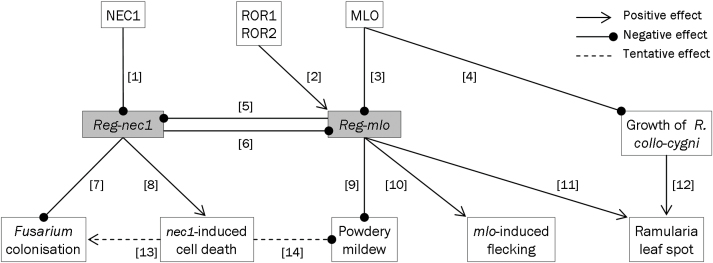
A hypothesis for the joint effect of NEC1 and MLO on various pathogenic fungi and cell death. The model is based on the following data: nec1-dependent cell death (CD) [1, 8] Fig. 6B, C; effect of nec1 on Fusarium colonisation [7] Fig. 6a; effect of mlo-5 on nec1-dependent traits [3, 5] Fig. 6; mlo-dependent stimulation of Ramularia collo-cygni (Rcc) fungus [4] and Ramularia leaf spot (RLS) symptoms [3, 11] Fig. 5, McGrann et al. (2014), Brown & Makepeace (2009); suppression of RLS [6, 11] but not Rcc growth [12] in nec1+MLO plants, Fig. 5; mlo-dependent mildew resistance [3, 9] Jørgensen (1992), Büschges et al. (1997); mlo-dependent CD [3, 10] Peterhänsel et al. (1997). Traits enhanced by ROR genes [2] are mildew resistance [10] (Freialdenhoven et al., 1996; Collins et al., 2003), mlo-dependent CD [11] (Peterhänsel et al., 1997), RLS [12] (McGrann et al., 2014), and Fusarium colonisation (Fig. 7; ROR1 tested but not ROR2). Growth of Rcc is not affected by ROR genes (McGrann et al., 2014). The Reg-nec1 and Reg-mlo components are hypothetical, as are the effects of nec1-dependent CD on Fusarium [13] (Fig. 6) and mildew [14] (Keisa et al., 2011). See Discussion and Supplementary Fig. S3 for detailed description of the model.